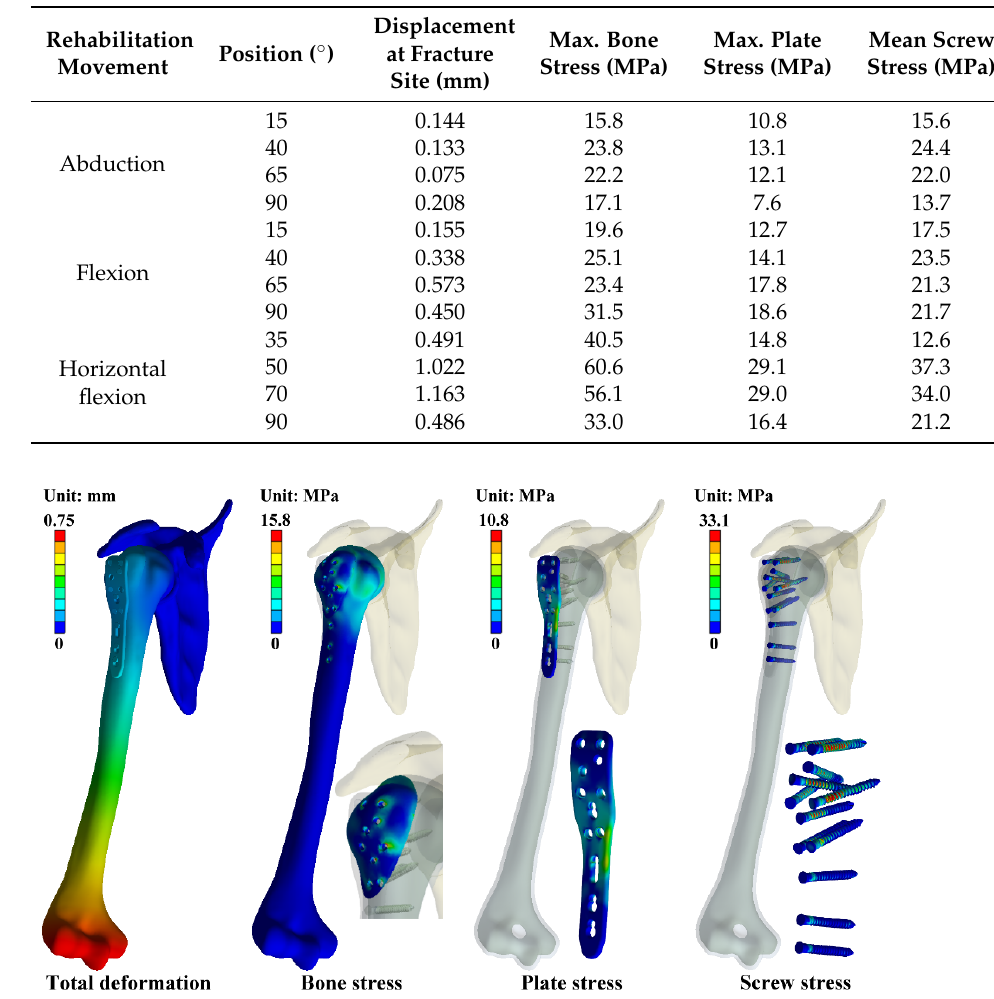
Table 1. The results of the finite element models under realistic muscle loading.